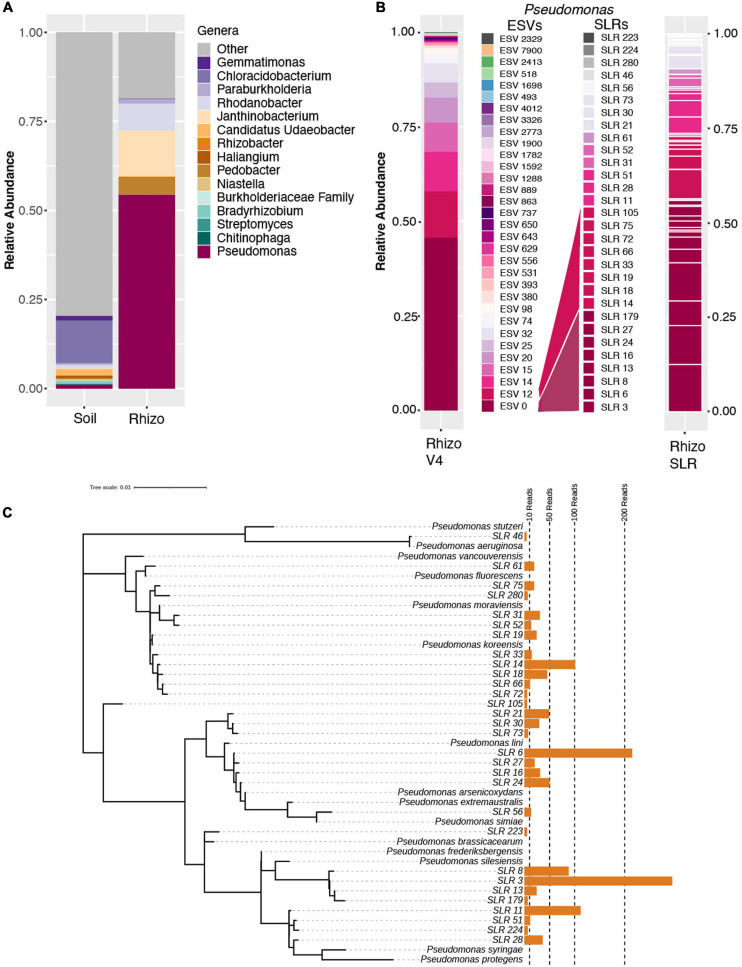
Synthetic long-read amplicon data reveal diversity within the Pseudomonas population. (A) Relative abundance barplots of the same fifteen genera identified as most abundant in the OTU dataset (Figure 1A) based on single-molecule long-read sequencing data of select 7-week rhizosphere and soil samples. (B) Relative abundance barplots of all ESVs (at left, as presented in Figure 1D) and synthetic long reads (SLRs, at right) belonging to the Pseudomonas genus. The mapping of SLRs to specific ESVs, as determined by a sequence similarity threshold of 97% in pairwise alignment over the V4 region, is indicated by the color of individual SLRs and their corresponding ESV map. Four SLRs with no identical match to any of the ESVs over the V4 region are indicated with shades of gray. (C) Tree of all 32 SLRs belonging to the Pseudomonas genus and the taxonomy of their best BLAST hits (considering only SLRs with at least 5 reads across the full dataset after normalization to 1500 reads per sample). Aligned by Muscle and ML Tree constructed in MEGA, visualized in iTOL. SLR 46 (top) is only found in the soil sample and is an outlier at the base of the tree (best match to Pseudomonas aeruginosa).